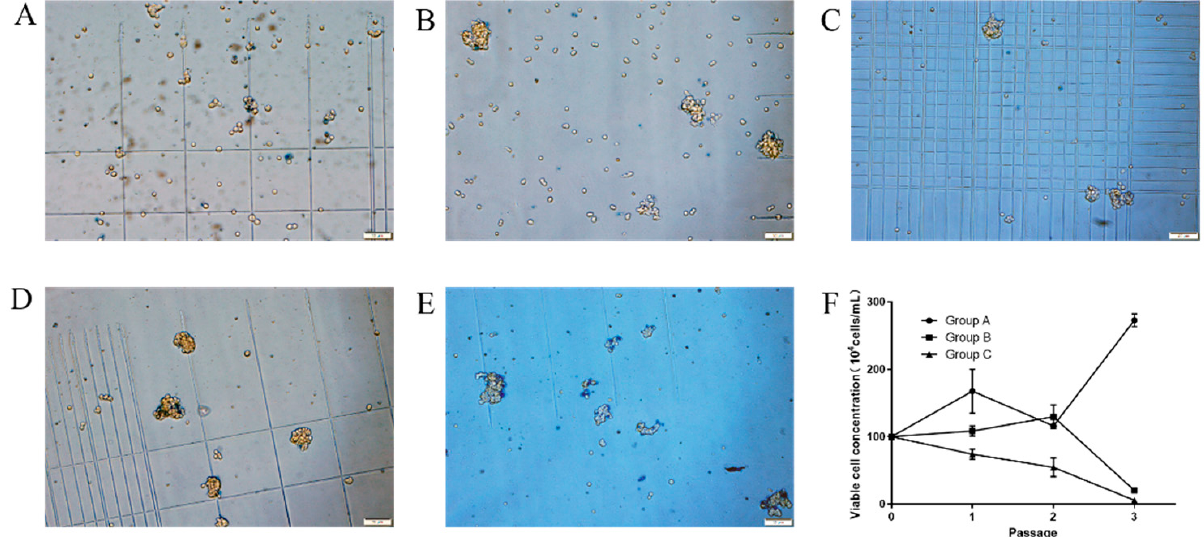
Figure 1. Screening of commercially available media for the suspension adaptation process of MDBK cells. Morphology of MDBK cells in passage 2 maintained in ST503 ( A ), CD MDBK 249 ( B ), OPM-MDBK SFM1 ( C ), Uni101 ( D ) and Bofit-S002 ( E ). Additionally, the growth curve ( F ) of MDBK cells in ST503 (Group A), CD MDBK 249 (Group B) and OPM-MDBK SFM1 (Group C). The scale bar (100 µm) is shown in the lower right corner of the picture ( A – E ).